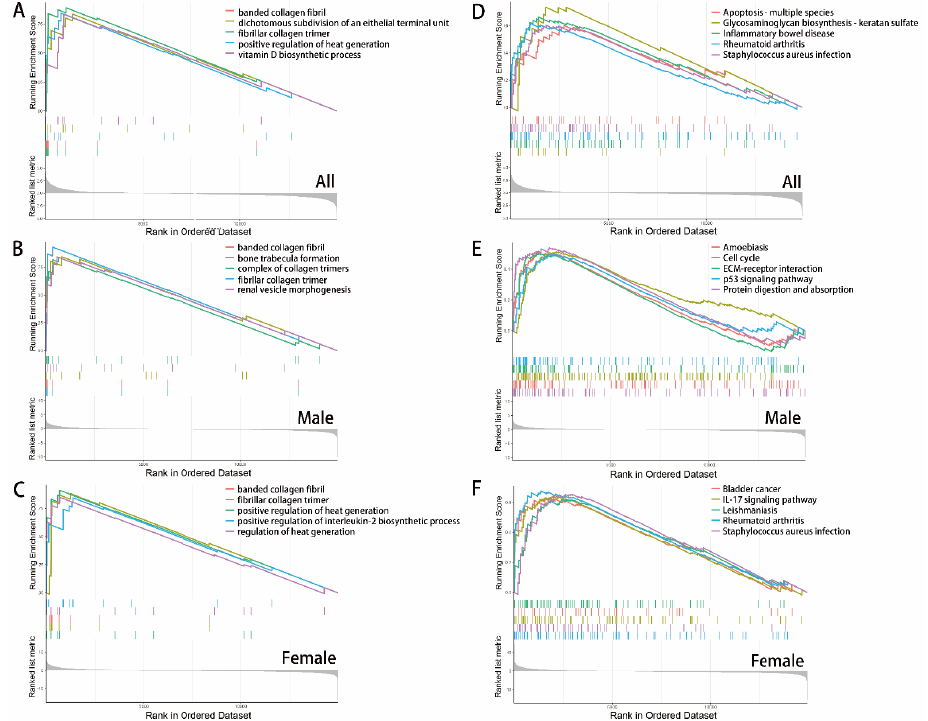
Figure 6. Gene set enrichment analysis in different sex. ( A ) GO gene sets enriched in AVF patients. ( B ) GO gene sets enriched in male AVF patients. ( C ) GO gene sets enriched in female AVF patients. ( D ) KEGG gene sets enriched in AVF patients. ( E ) KEGG gene sets enriched in male AVF patients. ( F ) KEGG gene sets enriched in female AVF